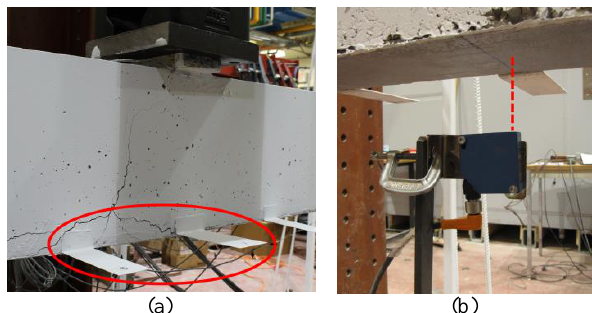
Figure 8. Close-up of two of the offset/witness plates (a), and one of the laser transducers (b)